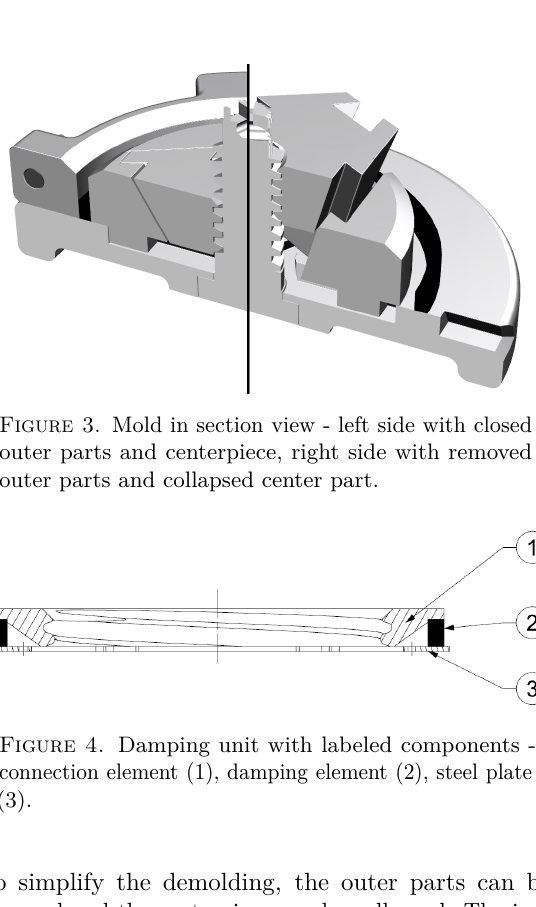
Figure 2. Constructed assembly of the Damper demonstrator (left) and damper demonstrator in section view with labelled components(right)